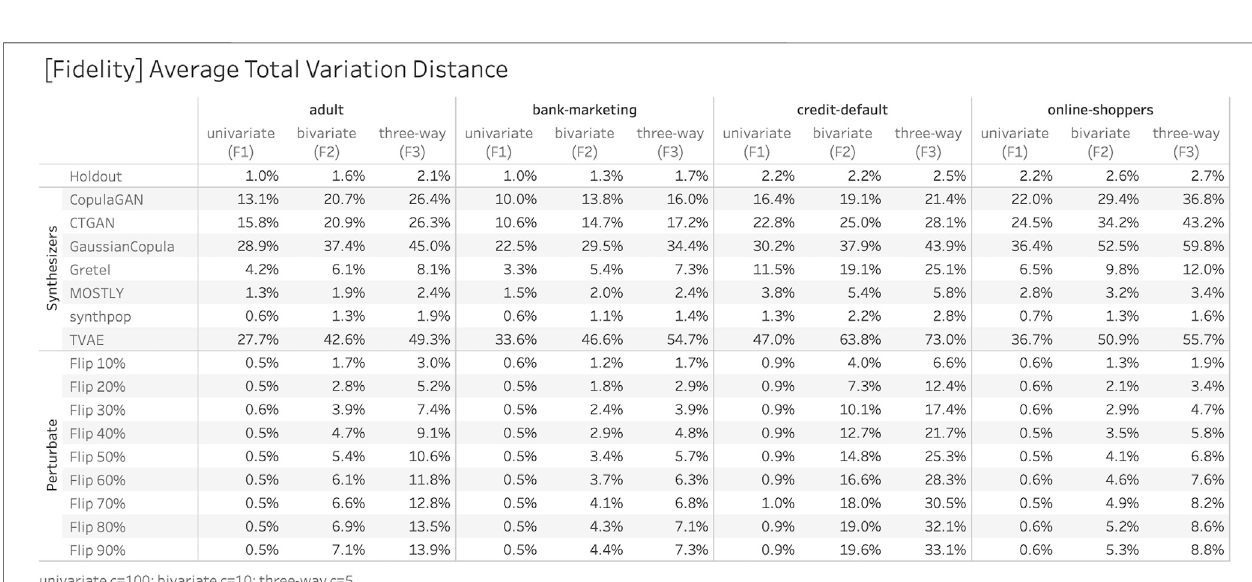
FIGURE 9 | Fidelity measures F 1 , F 2 , and F 3 of the presented empirical study, across all four datasets, seven synthesizers, and in comparison to basic data perturbation techniques. The closer the fi delity scores are to the respective scores of the holdout, the better the synthetic data represent the distributions in the original training